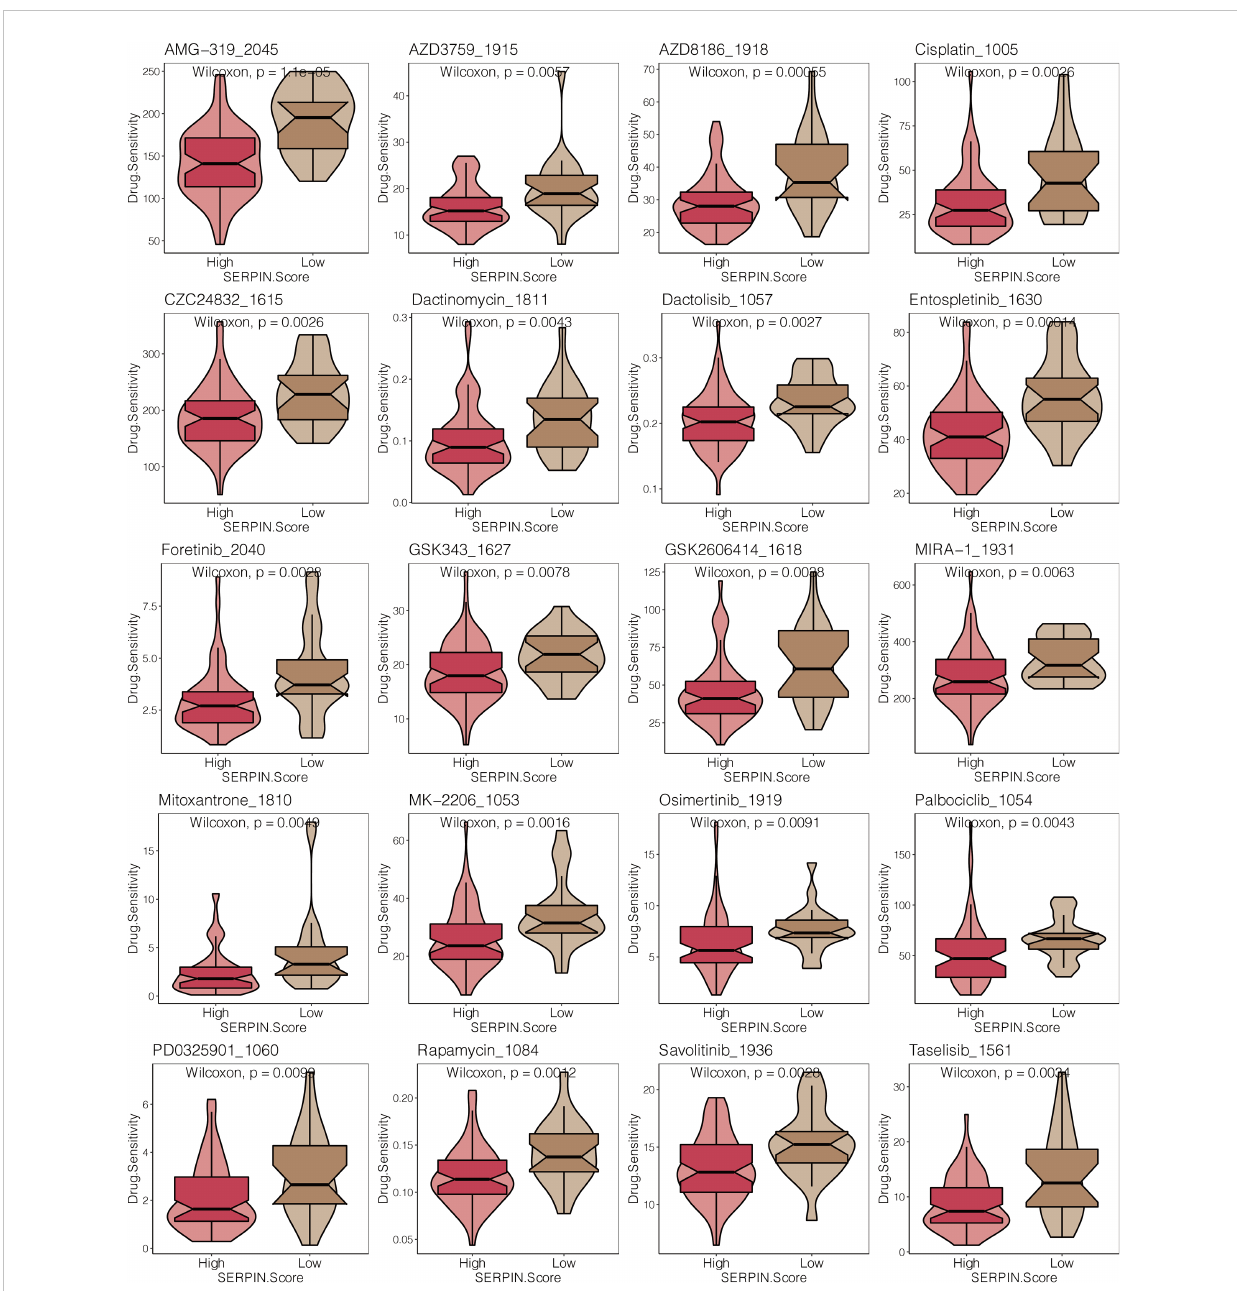
FIGURE 10 Drug prediction of the SERPINH1-related score. The drug sensitivity of 23 chemotherapy drugs in the two SERPINH1-related score-strati fi ed